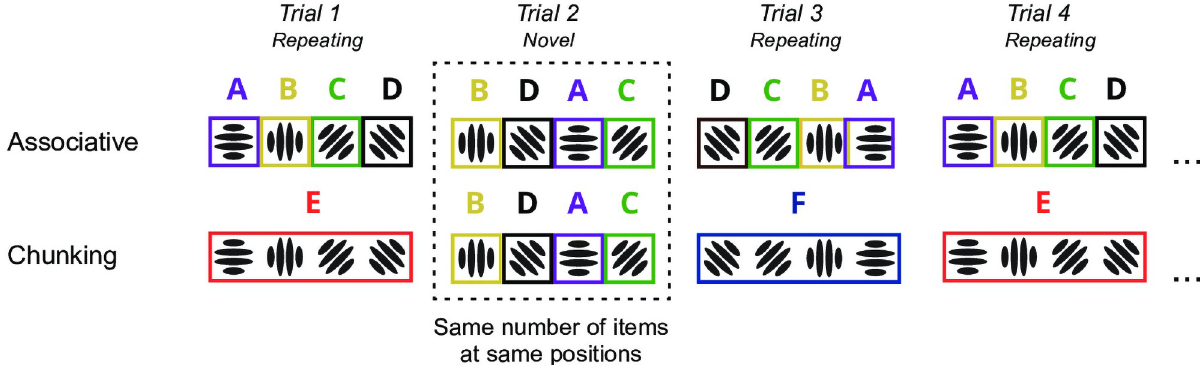
Fig 4. Sequence representation in associative and recoding models. The figure illustrates difference in sequence representations for four individual sequences: associative representations are displayed at the top and chunk codes at the bottom row. Differently coloured letters and boxes refer to individual item codes. For the chunk recoding model (bottom) item codes reflect the optimal chunking structure for the sequences presented in our experiment. Note that the representation of the novel sequence (Trial 2) contains the same number of item codes at same positions for both models.